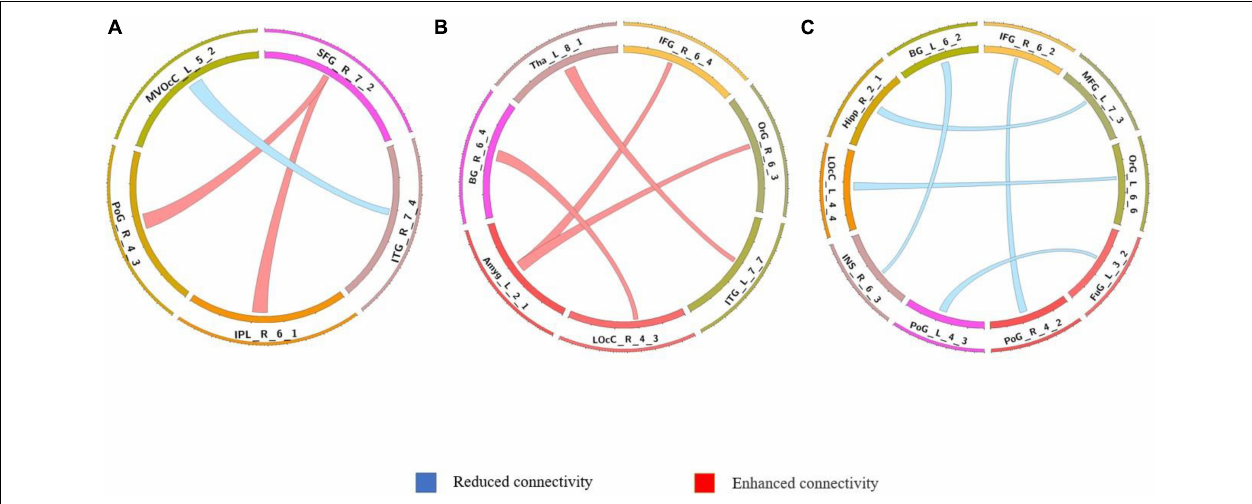
FIGURE 6 | Comparison of dynamic differences in functional connectivity with global signal regression (overlap = 0.9). (A) AVHs group compared with the non-AVHs group; (B) AVHs group compared with the NC group; (C) non-AVHs group compared with the NC group. Increased connectivity shown in red and decreased shown in blue.